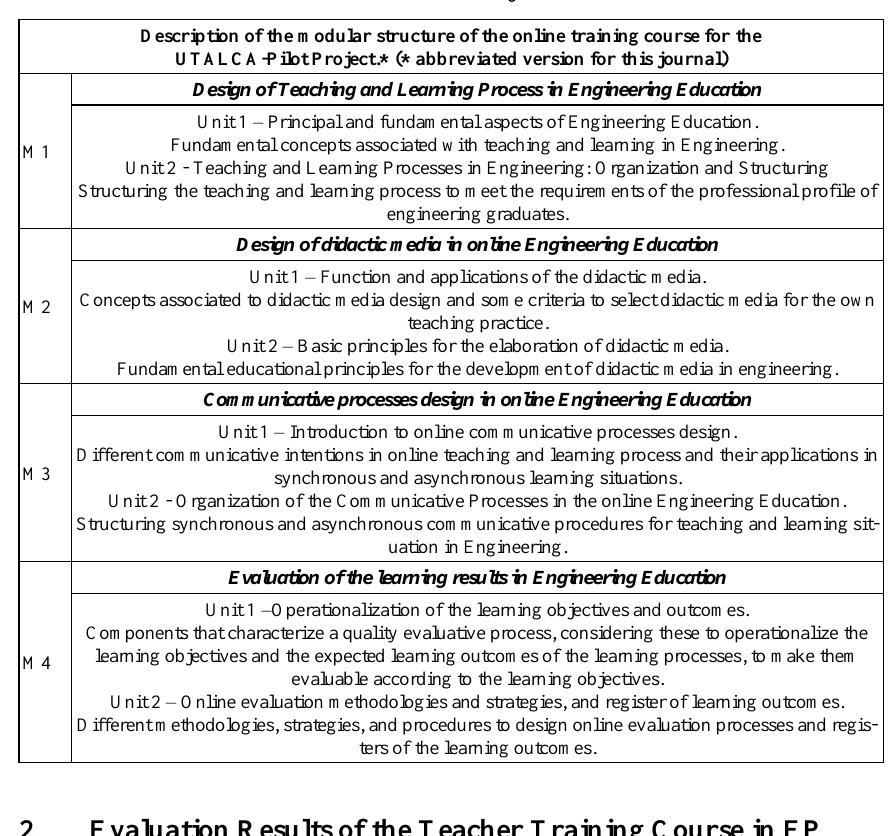
Table 2. Description of the modular structure of the online training course for the UTALCA- Pilot